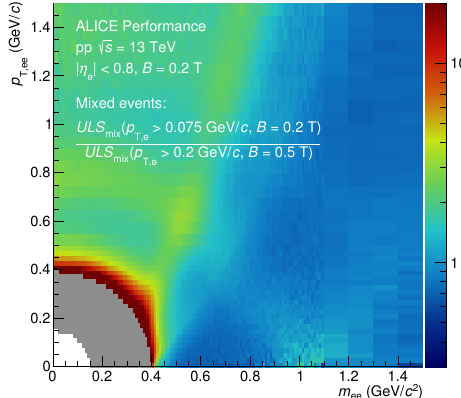
Figure 3. Relative acceptance difference between low- and standard-field configuration as a function of m ee and p T,ee due to the lower single-electron p T selection and increased TOF acceptance at low momenta.